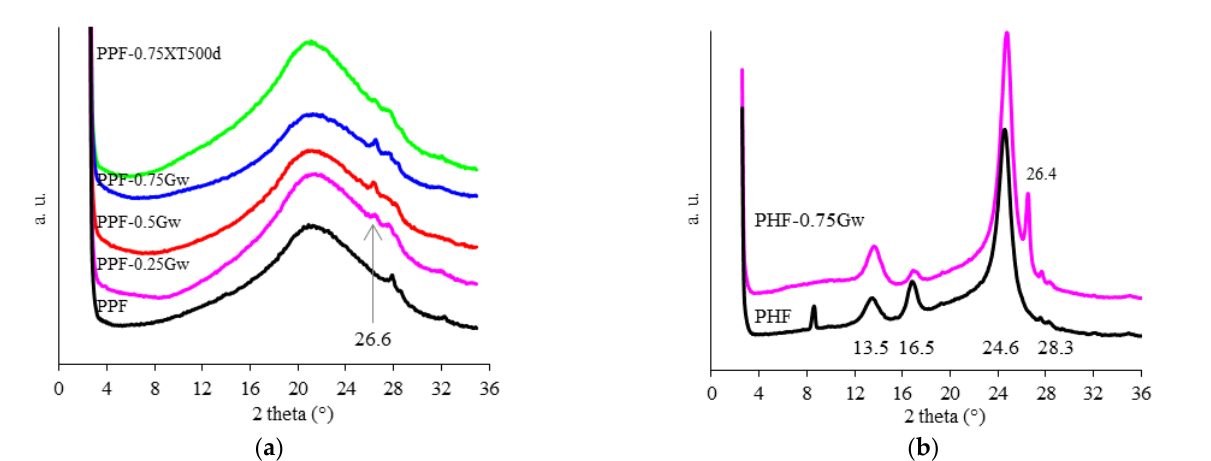
Figure 6. Diffractometric curves of ( a ) PPF samples (the arrow indicates the reflection attributed to (002) diffraction peak of graphene) and ( b ) PHF samples.